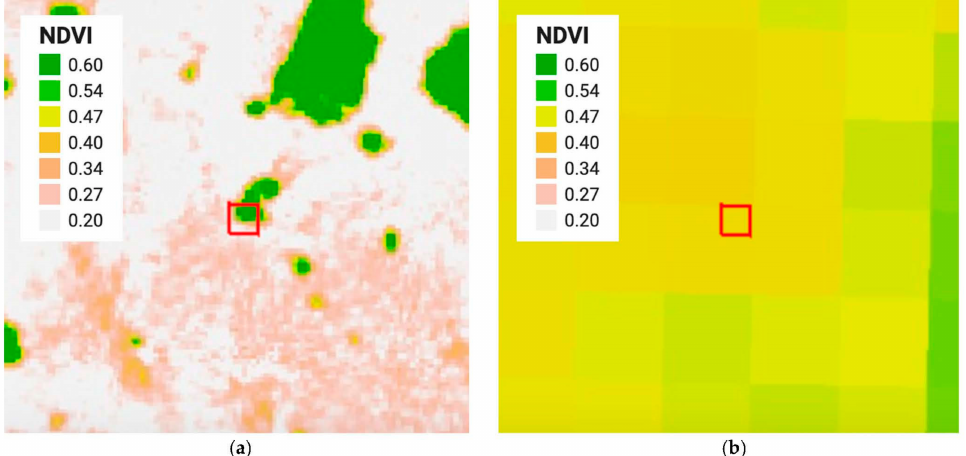
Figure 3. A 1 m 2 quadrat overlaid on the NDVI image derived from ( a ) the 0.15 m ArborCam image acquired on the 15 October 2020, and ( b ) the 3 m PlanetScope image acquired on 23 October